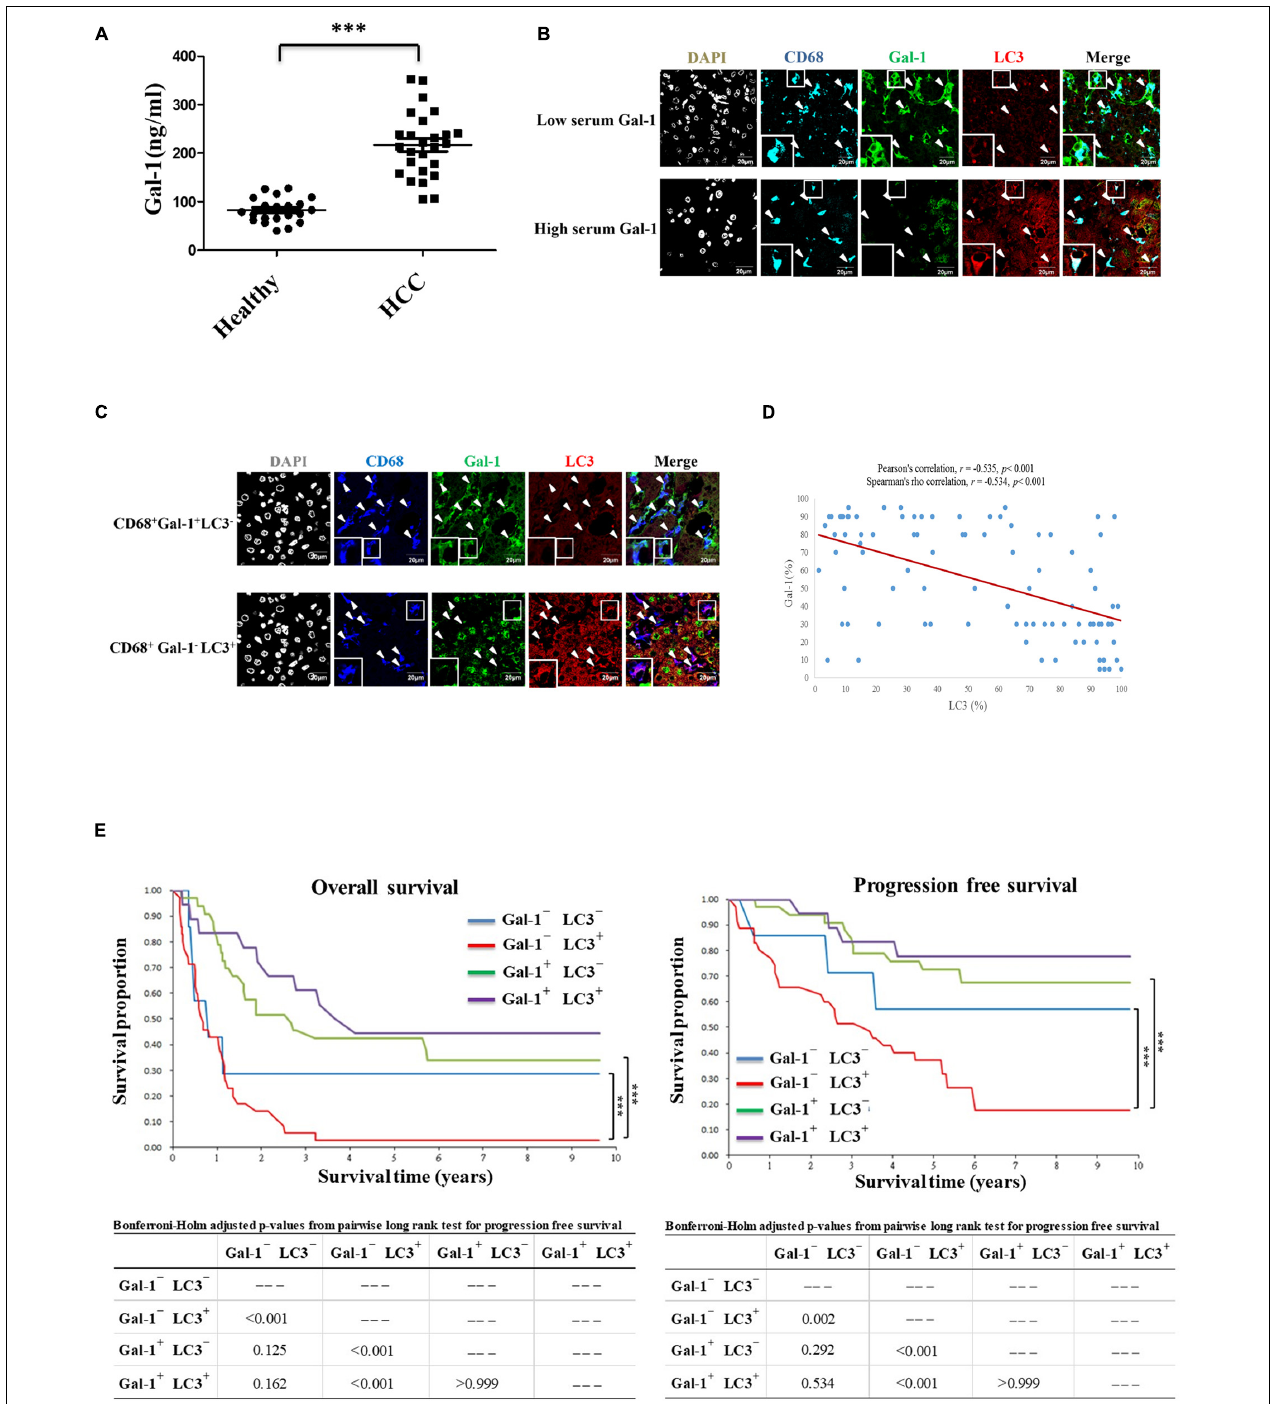
FIGURE 5 | Intratumoral Gal-1 - LC3 + TAMs correlate to the poor OS and PFS rates of HCC patients. (A) Serum levels of Gal-1 in healthy donors ( n = 21) and HCC patients ( n = 25) were analyzed by ELISA. ∗∗∗ p < 0.0001. (B) Liver tumor sections from HCC patients with high or low serum levels of Gal-1 were stained with anti-CD68 (blue), anti-Gal-1 (green), and anti-LC3 (red) antibodies. Representative images show the protein distribution as observed by confocal microscopy. Scale bar = 20 µ m. (C–E) Liver tumor sections of 93 retrospectively recruited HCC patients were stained with anti-CD68 (blue), anti-Gal-1 (green), and anti-LC3 (red) antibodies. Representative images show the protein distribution as observed by confocal microscopy (scale bar = 20 µ m) (C) . The expression correlation between LC3 and Gal-1 in CD68 + TAMs was analyzed by Bivariate correlation analysis using Pearson’s correlation (r = − 0.535, p < 0.001) as well as Spearman’s correlation (r = − 0.534, p < 0.001) (D) . The OS and PFS rates of TAMs carrying Gal-1 - LC3 - , Gal-1 - LC3 + , Gal-1 + LC3 - , or Gal-1 + LC3 + HCC patients were analyzed by Kaplan-Meier survival analyses (E) .